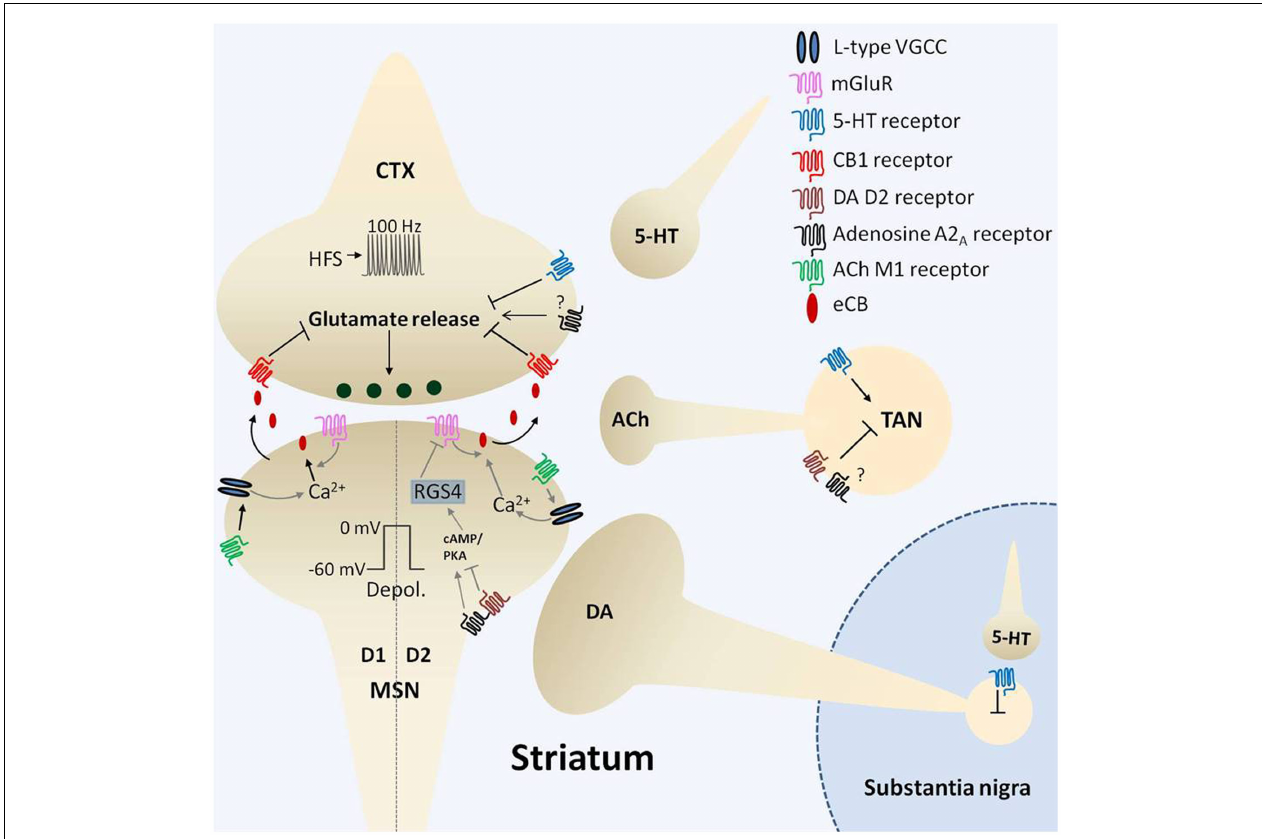
FIGURE 1 | Mechanisms of corticostriatal long-term depression (LTD). Four, one second bouts of afferent (corticostriatal, CTX) stimulation at 100Hz (high frequency stimulation, HFS) synchronized with postsynaptic medium spiny neuron (MSN) depolarization (depol.) to 0 mV every ten seconds induces endocannabinoid (eCB)-mediated LTD (eCB-LTD). Induction of eCB-LTD involves metabotropic glutamate receptor (mGluR) activation as well as suppression of cholinergic tone that requires dopamine (DA) D2 receptor activation on tonically active cholinergic interneurons (TANs). Relief of cholinergic tone on M1 acetylcholine (ACh) receptors, coupled with postsynaptic depolarization, enhances activation of L-type voltage-gated calcium channels (VGCCs) resulting in calcium influx (Ca 2 + ).This triggers eCB production and subsequent liberation